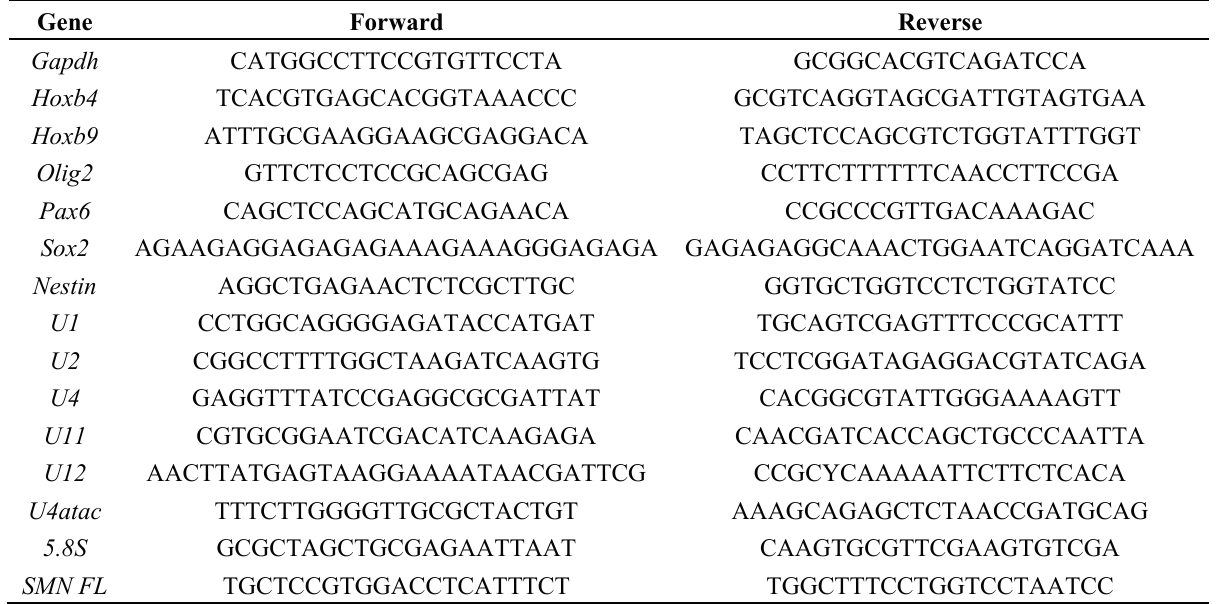
Table 2. Oligonucleotide